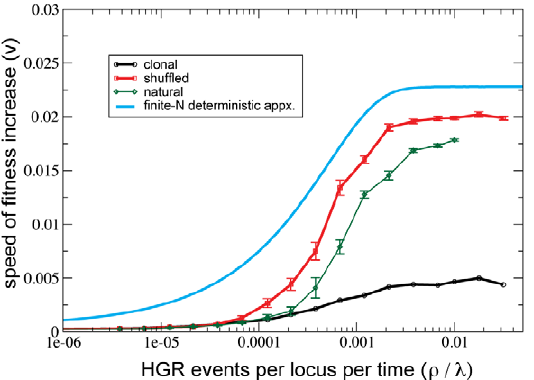
Figure 2. HGR accelerates adaptive evolution (i.e. positive selection) on a smooth fitness landscape. The initial level of genetic diversity is varied from high (‘‘shuffled’’) to medium (‘‘natural’’) to low (‘‘clonal’’). Shuffled populations initially contained sequences obtained by randomly placing 30 ‘‘ones,’’ whereas clonal populations initially contained one unique sequence. ‘‘Natural’’ initialization repre- sents an abrupt displacement from mutation/selection/drift balance at the fitness peak. v was measured during the interval in which the mean number of ‘‘ones’’ passed between 68 and 72 . Averages were taken over 10 replicates. Error bars denote one standard error. Parameters are k ~ 10 5 , m o ~ 10 { 3 : 3 , b ~ 1 = 100, l ~ 100, d ~ 0 : 2, c ~ 0 : 38 .